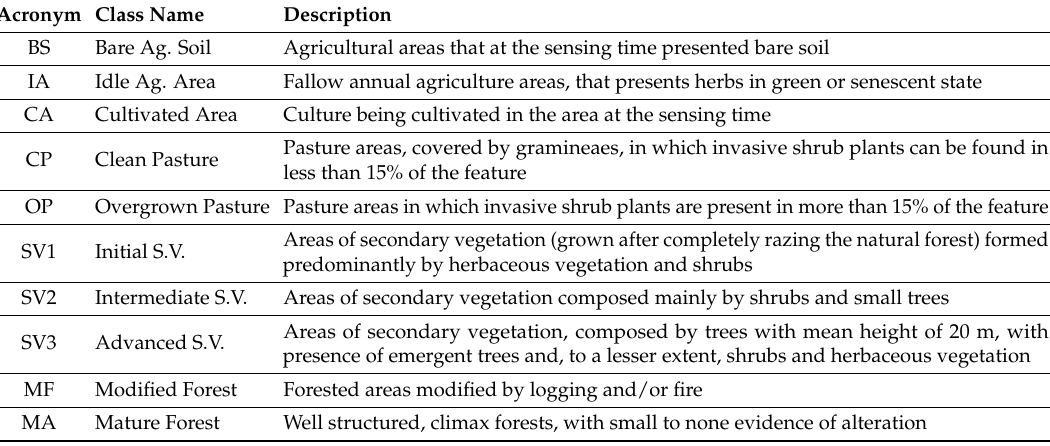
Table 1. Land cover classes